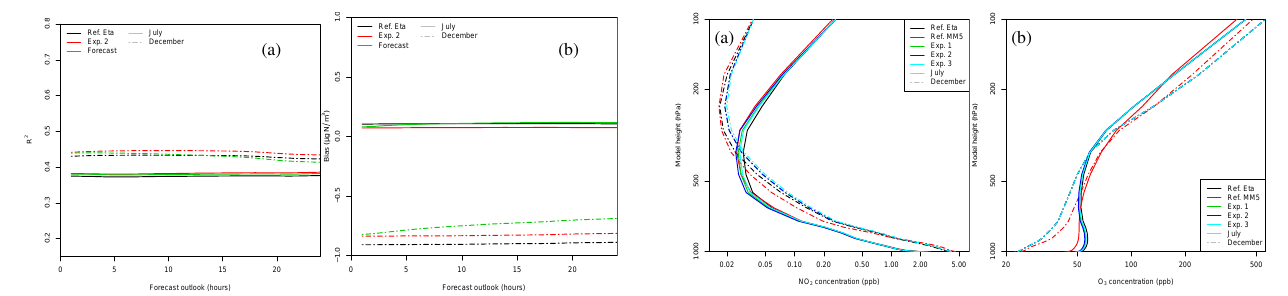
simulation,thelinetypedenotesthemonthinquestion.